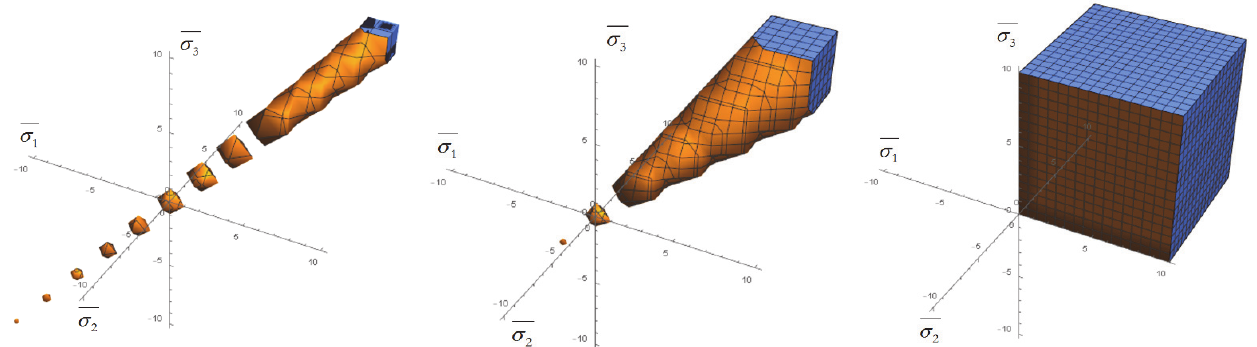
Figure 4: Failure surfaces according to a Mohr-Coulomb model assuming  changing from 0 up to 1 with a step of